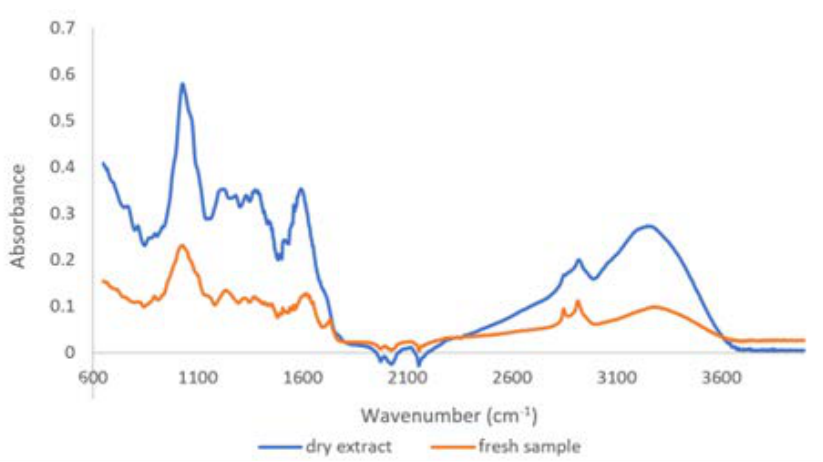
Figure 1. ATR-FTIR spectra of T. erecta flowers and plant materials.